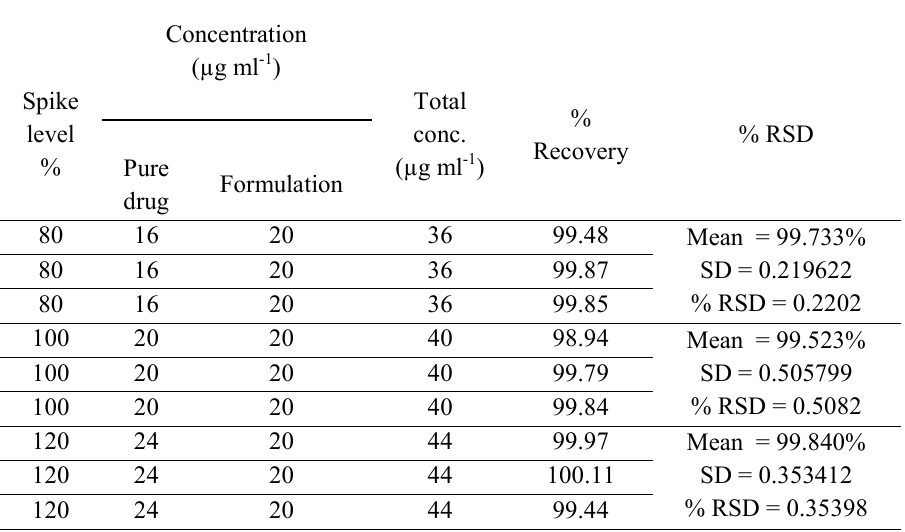
Table 3: Accuracy study of Etoricoxib